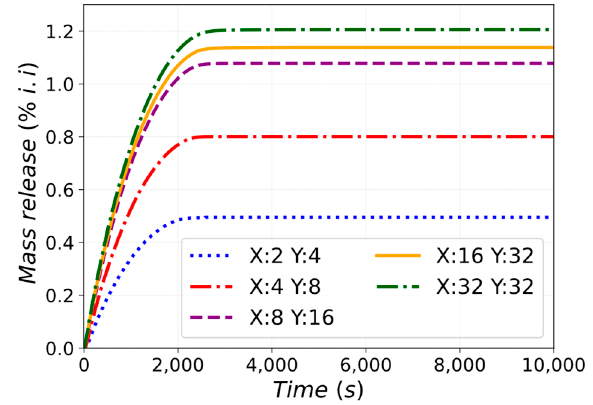
Figure 24. Direct unfiltered release of HTO (%i.i).